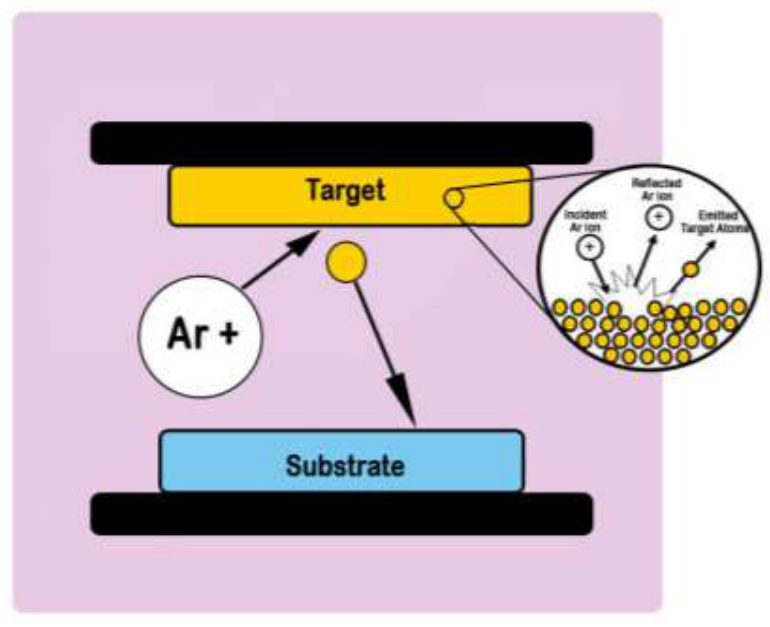
Figure 1: Scheme of DC diode sputtering